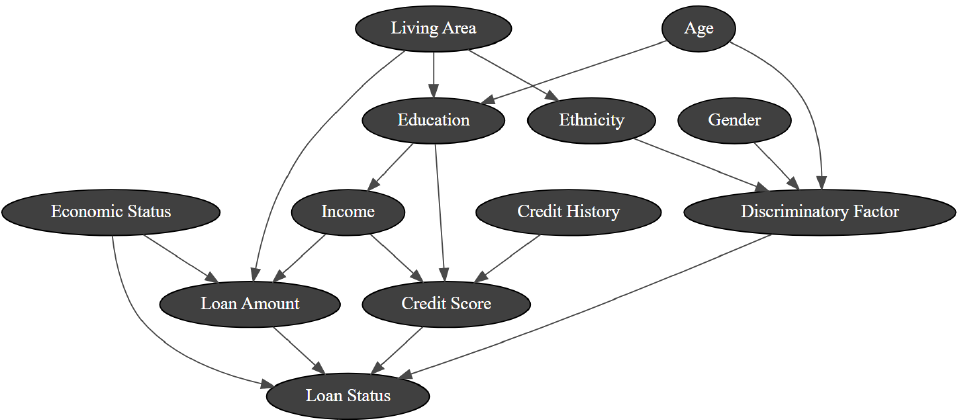
Figure 3. Loan approval network: this structure could represent a real scenario that can be used to produce a synthetic